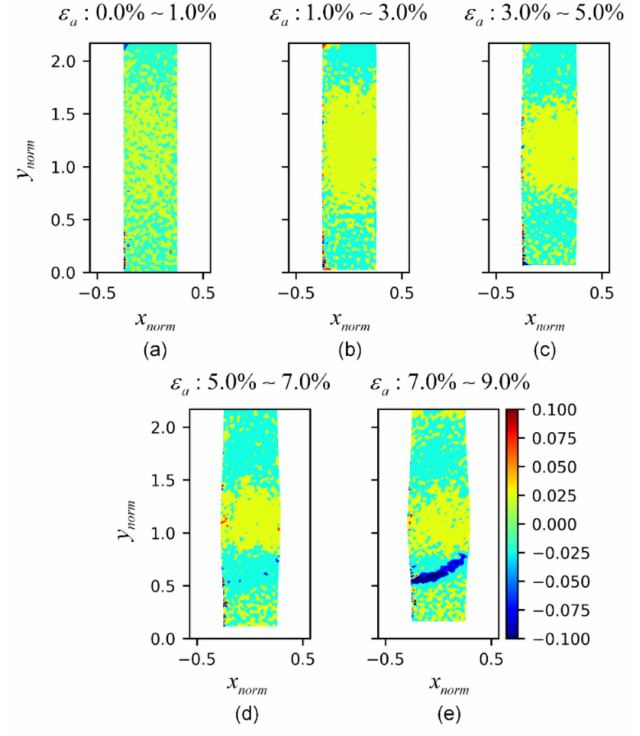
Figure 13. Evolution of divergence field div U of test 121304d: ( a ) axial strain 0.0%–1.0%; ( b ) axial strain 1.0%–3.0%; ( c ) axial strain 3.0%–5.0%; ( d ) axial strain 5.0%–7.0%; ( e ) axial strain 7.0%–9.0%.